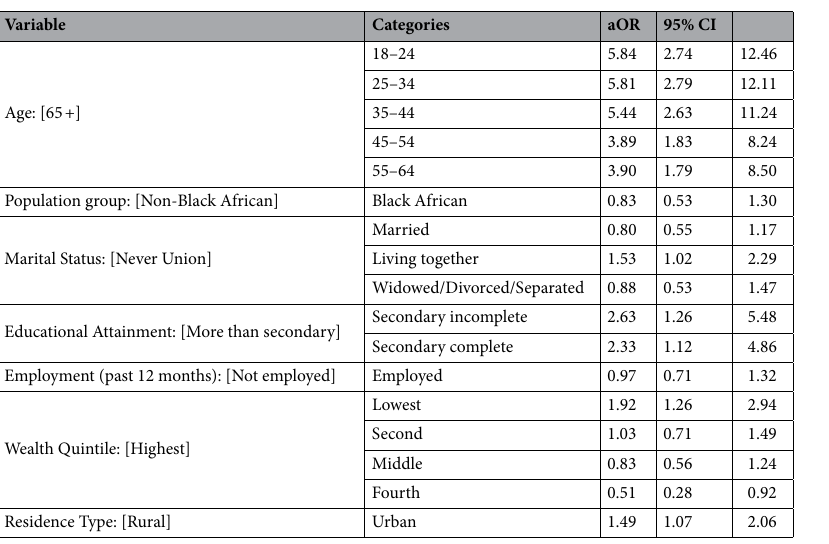
Table 3. Sociodemographic correlates of living inside/outside physical IPV syndemic area based on logistic regression.